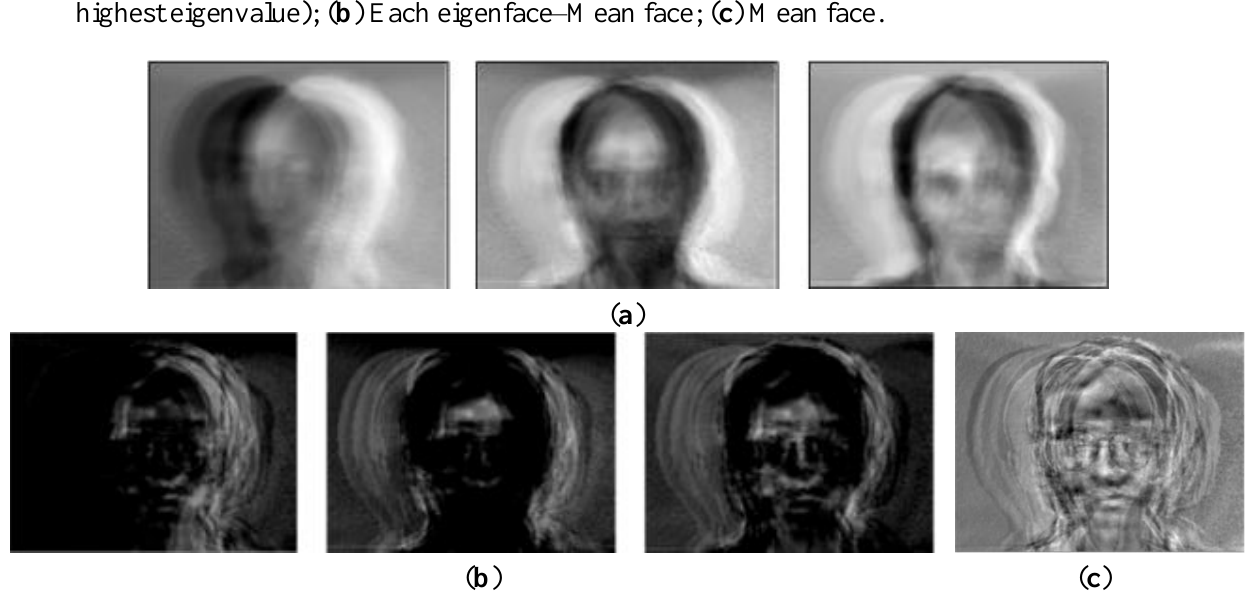
Figure 2. Eigenfaces in descending order of eigenvalue size: ( a ) Eigenfaces